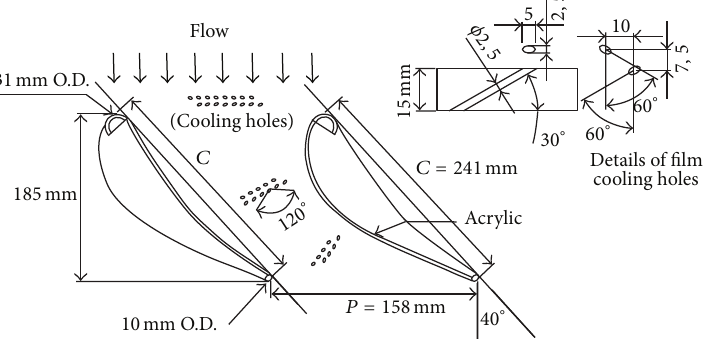
Figure 1: Two-half-vane test model and film cooling holes in the present study.